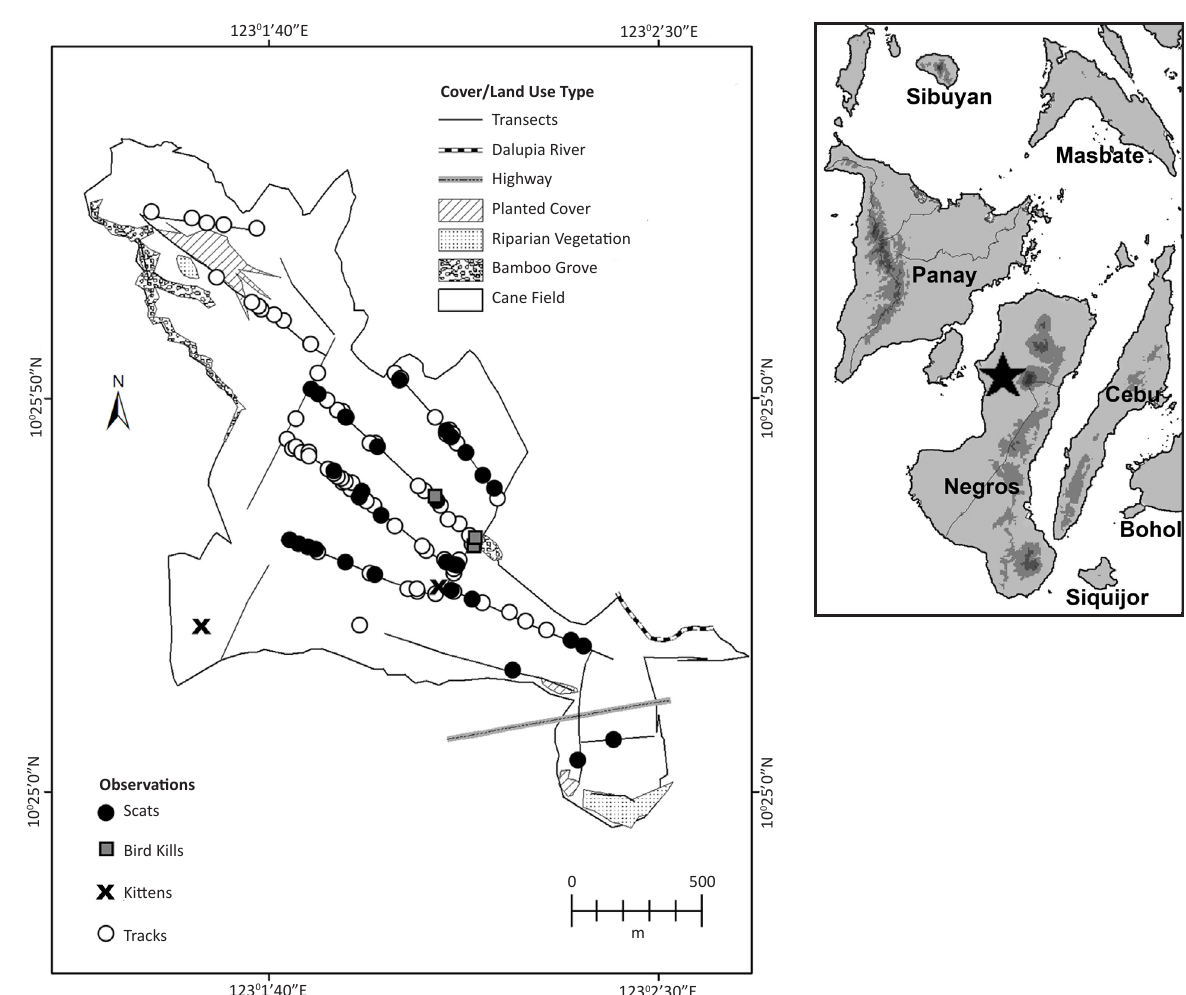
Figure 1. Map of the study site showing where spoors were observed on established transects relative to habitat type (see Methods). It also